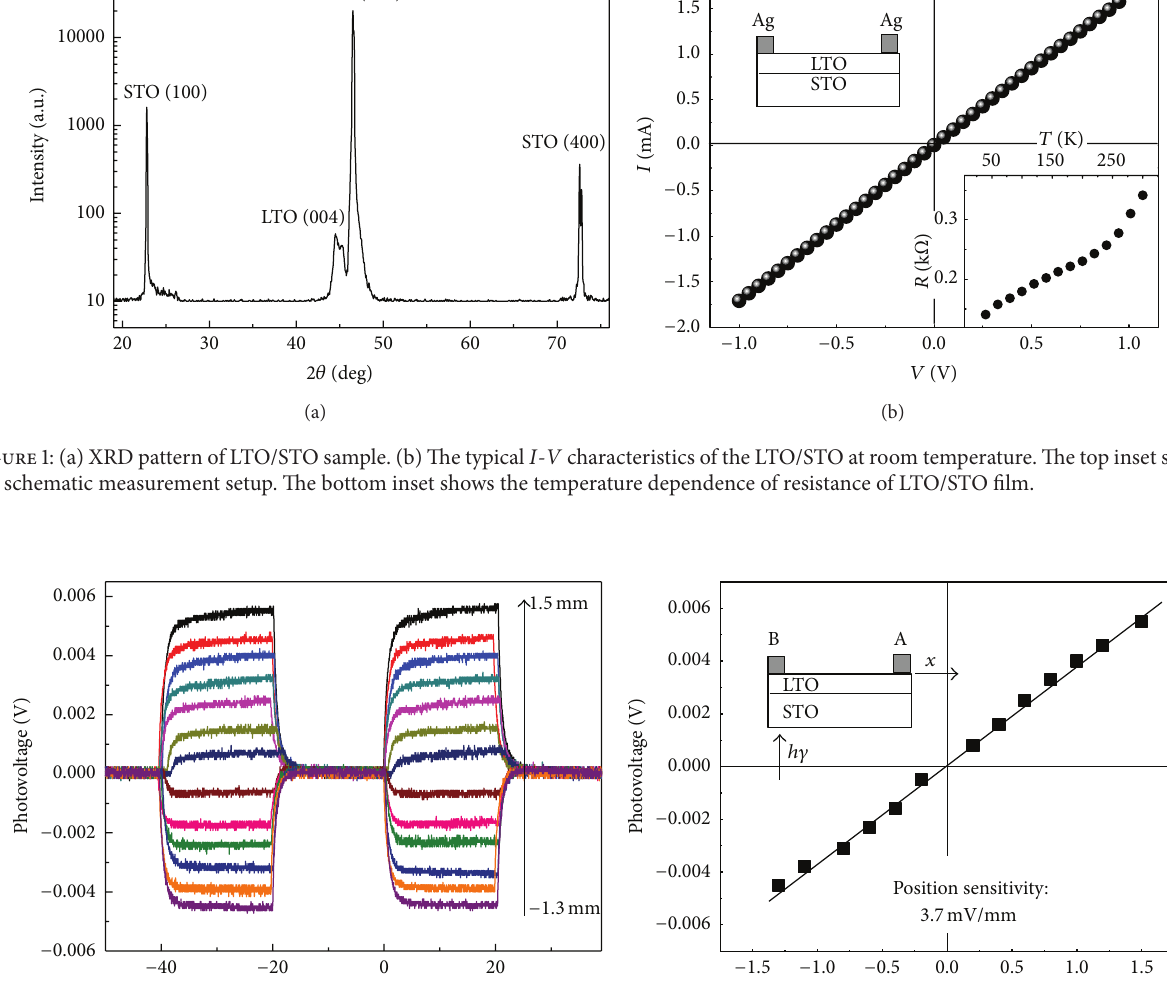
surface. A small area of 1 mm diameter was irradiated on the LTO/STO interface by a 1064 nm continuum solid state